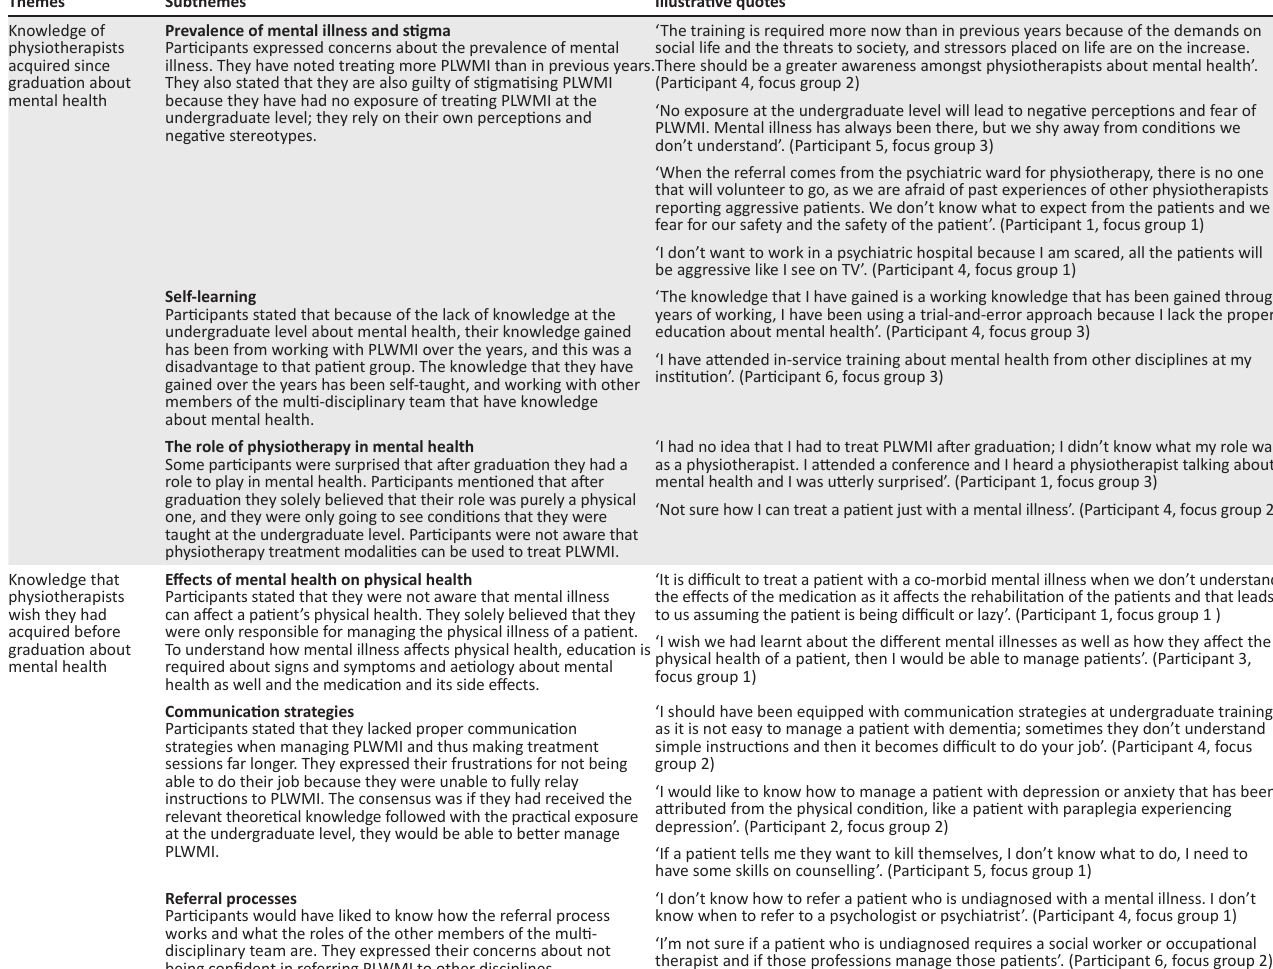
TABLE 3. Emergent themes from focus